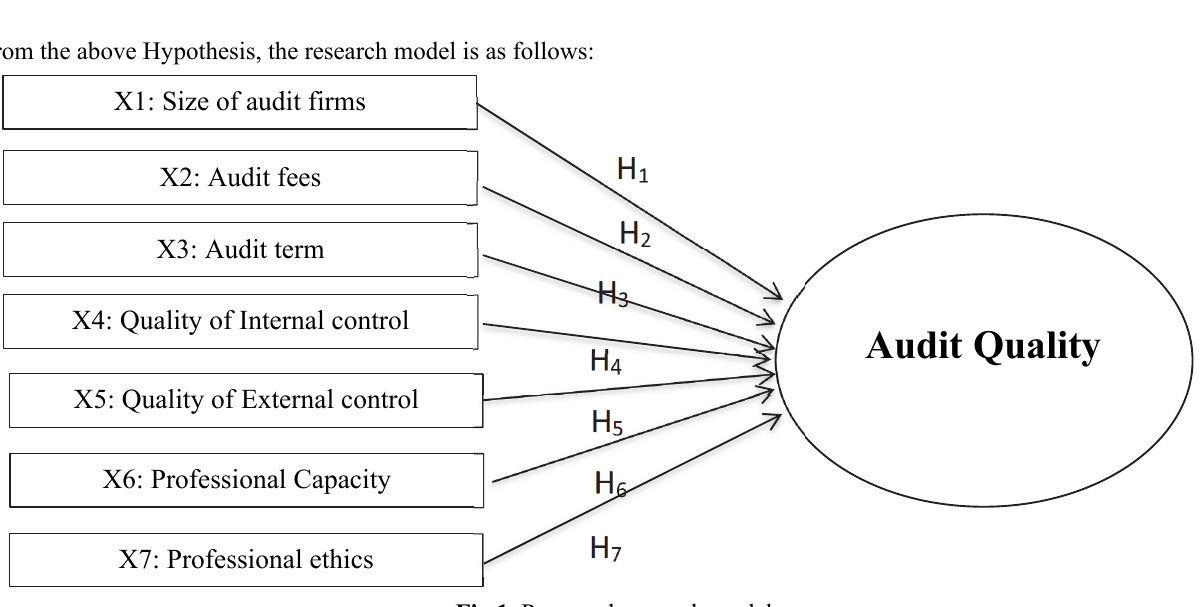
Fig 1. Proposed research